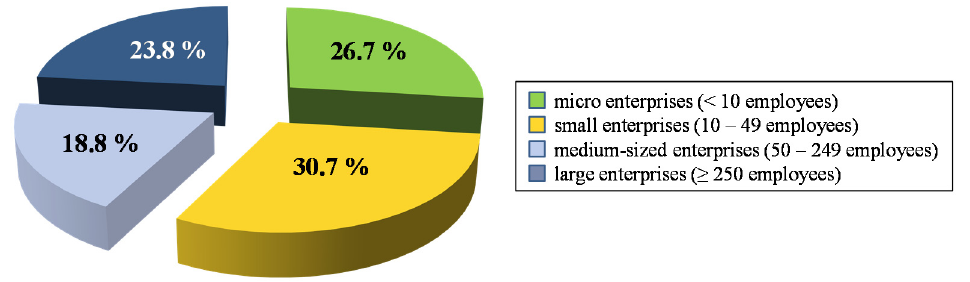
Figure 2. Classification of companies according to their size (=count of employees).